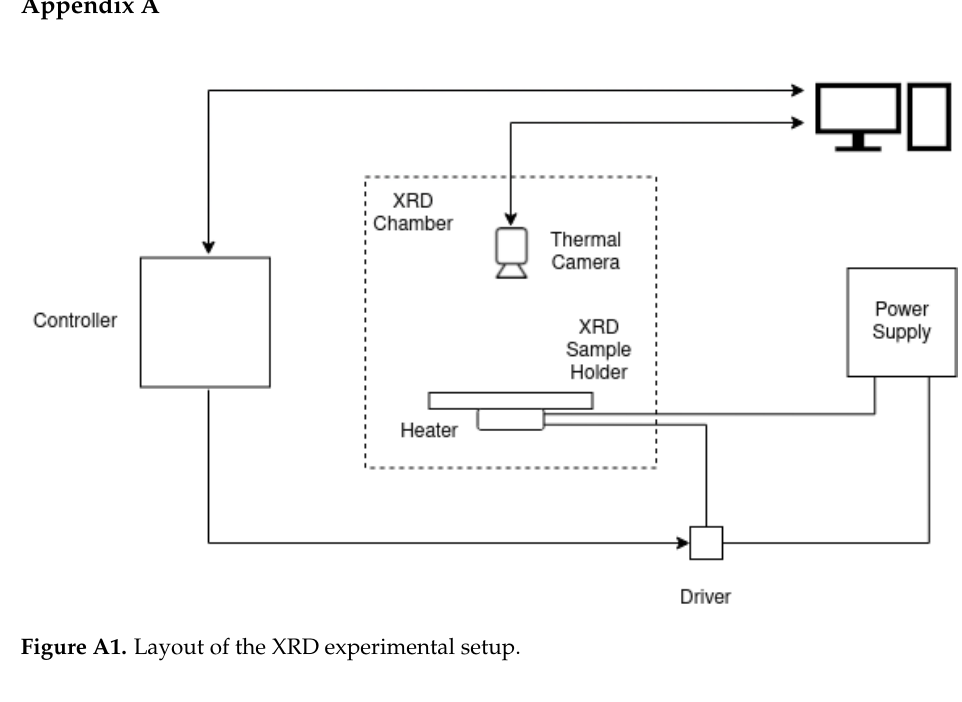
Figure A1. Layout of the XRD experimental setup.